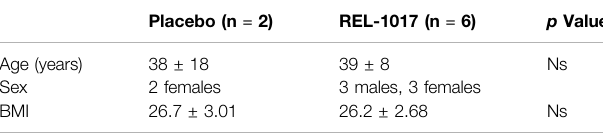
TABLE 1 | Demographic characteristics of the subjects enrolled in the study.